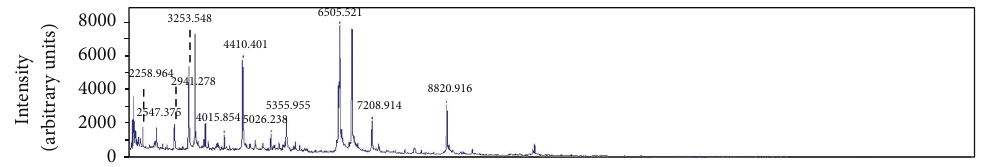
Figure 2: Mass spectral profile of the Nocardia farcinica isolate obtained from colonies grown on Columbia blood agar after 48 hrs of